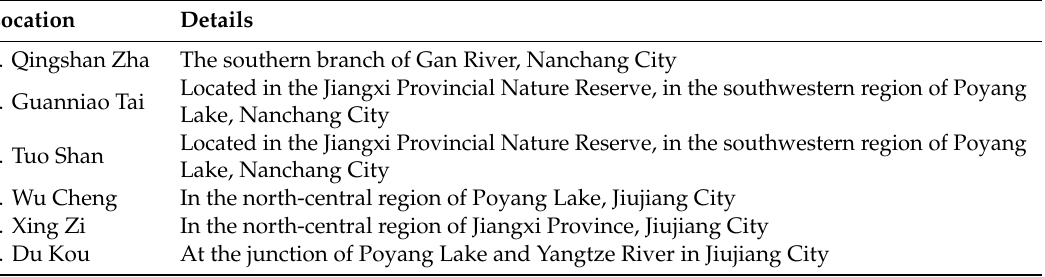
Table 1. Sites sampled in the Poyang Lake.